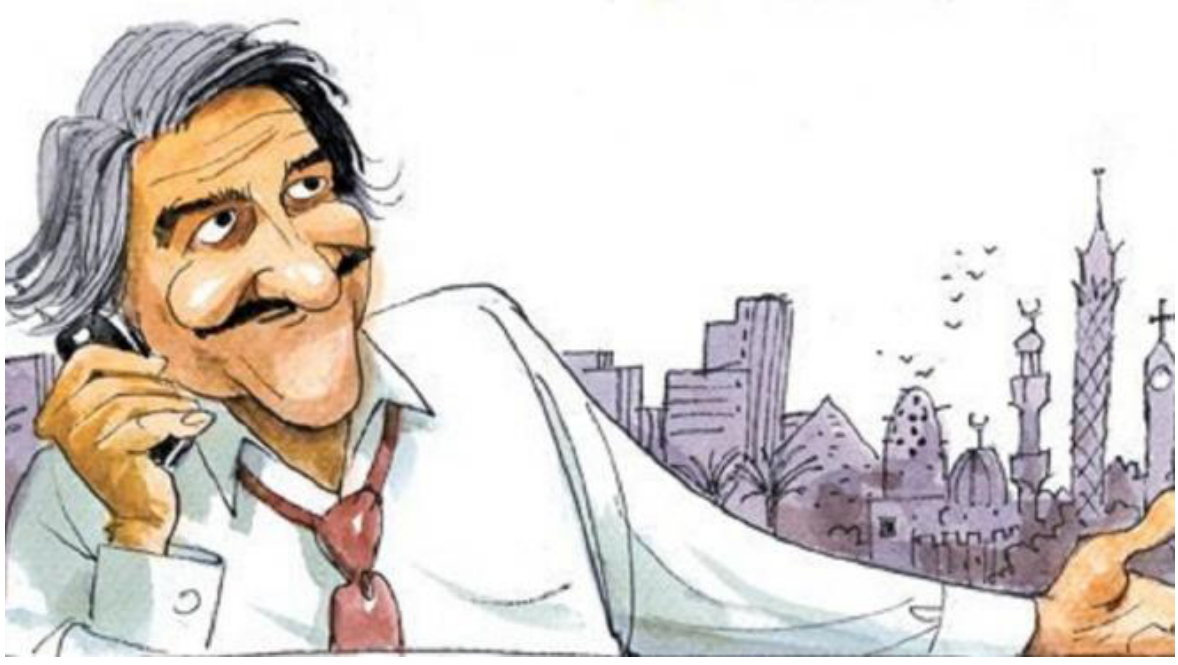
Figure 7 the work of the Artist Mostafa